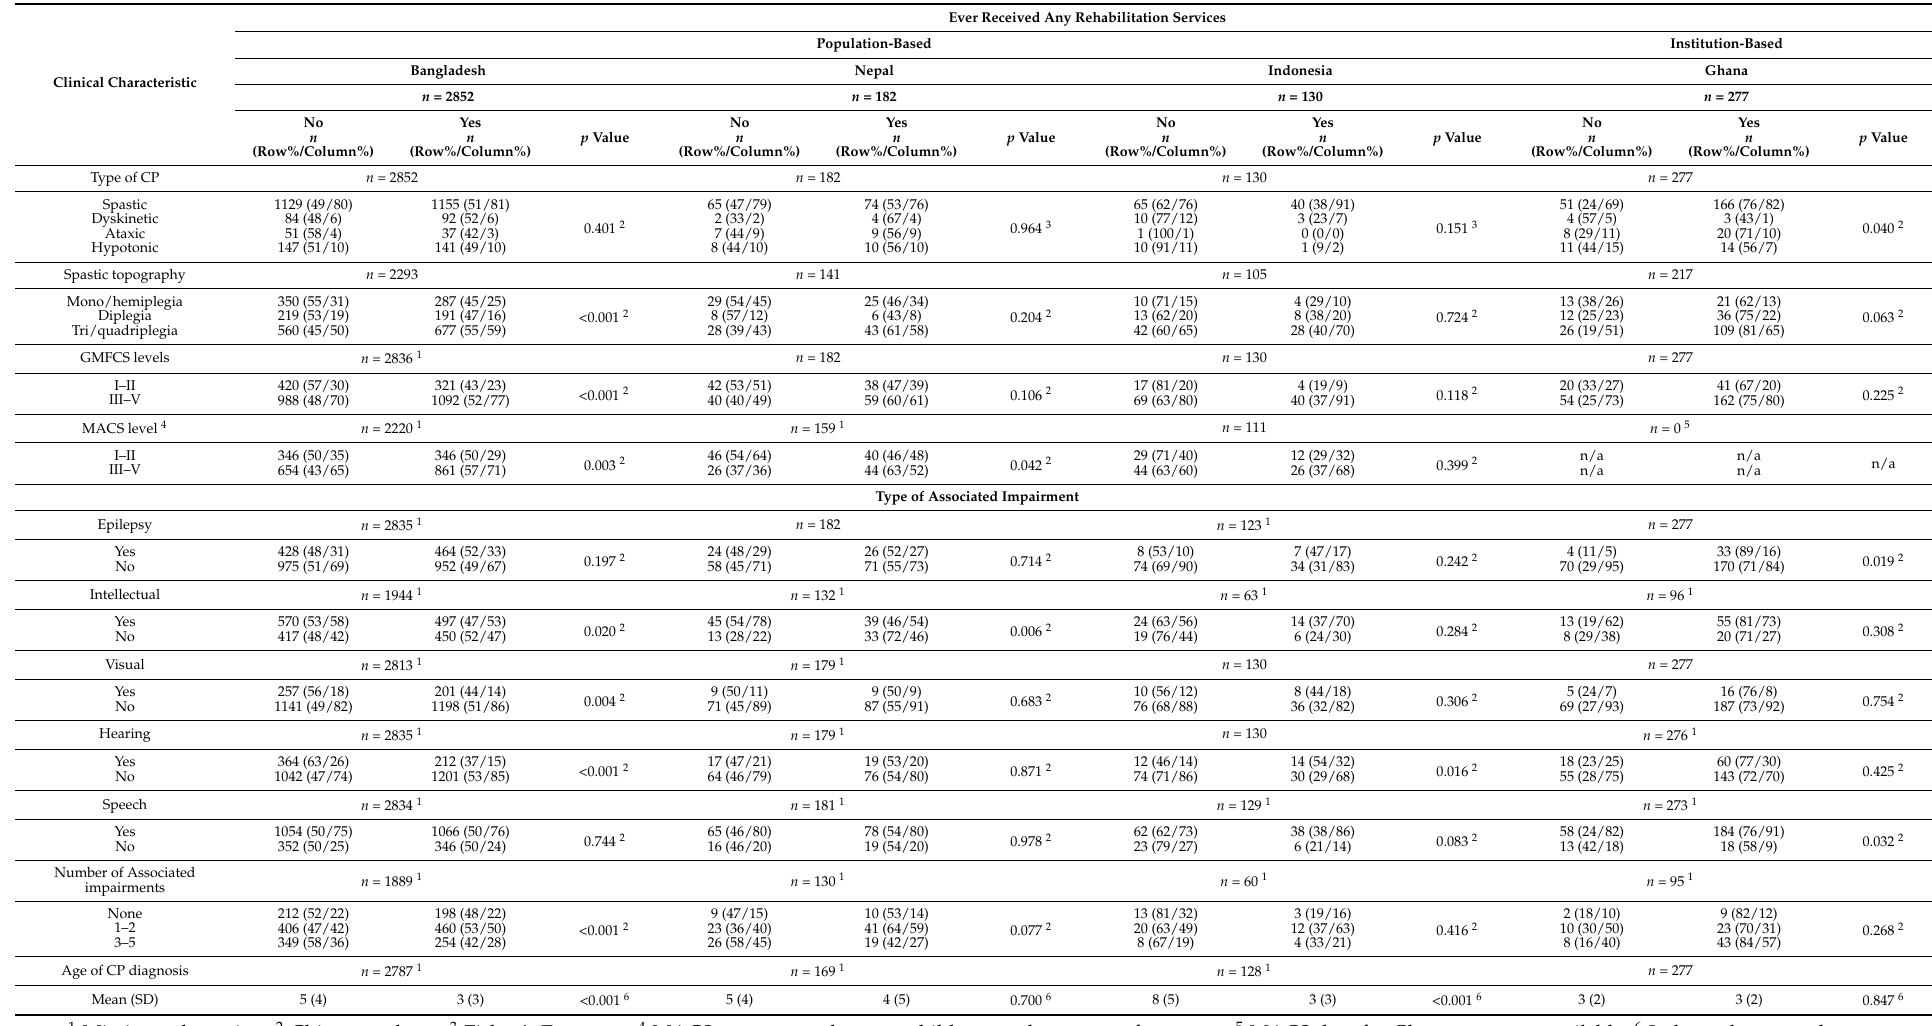
Table 3. Distribution of clinical factors according to rehabilitation status of children with CP in Bangladesh, Nepal, Indonesia, and